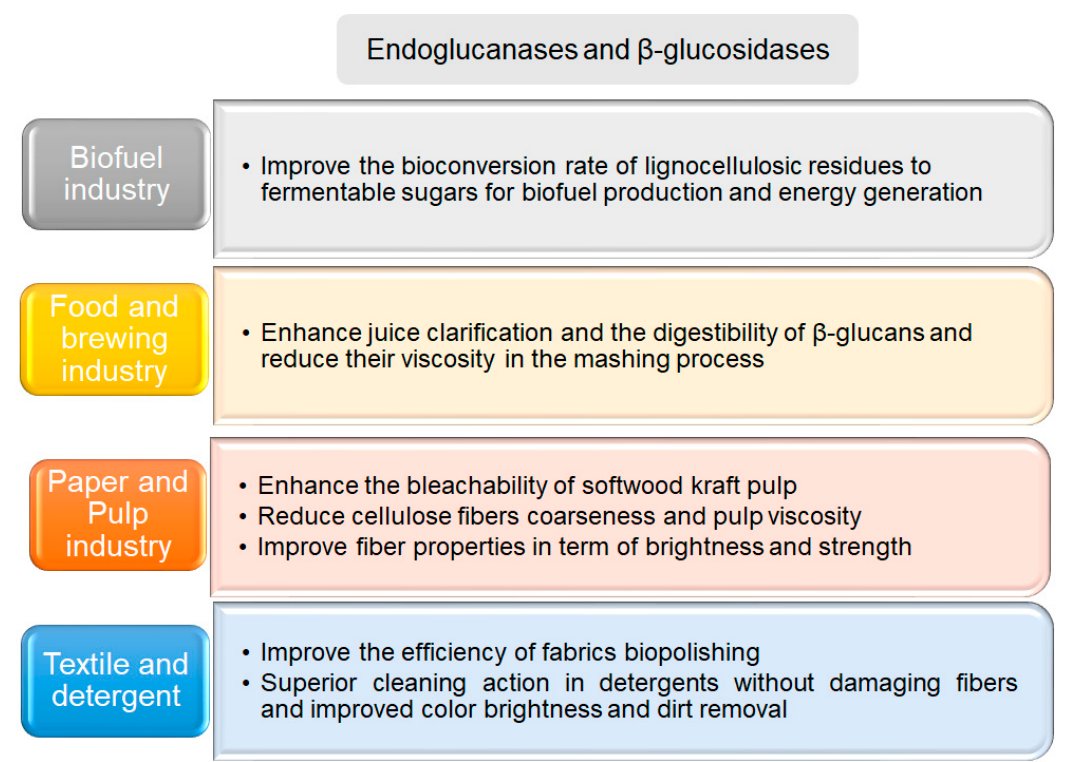
Figure 4. Applications of cellulose degrading enzymes. The main applications of hyperthermophilic enzymes from different Archaea are summarized in the corresponding text box [8,79,81–85].